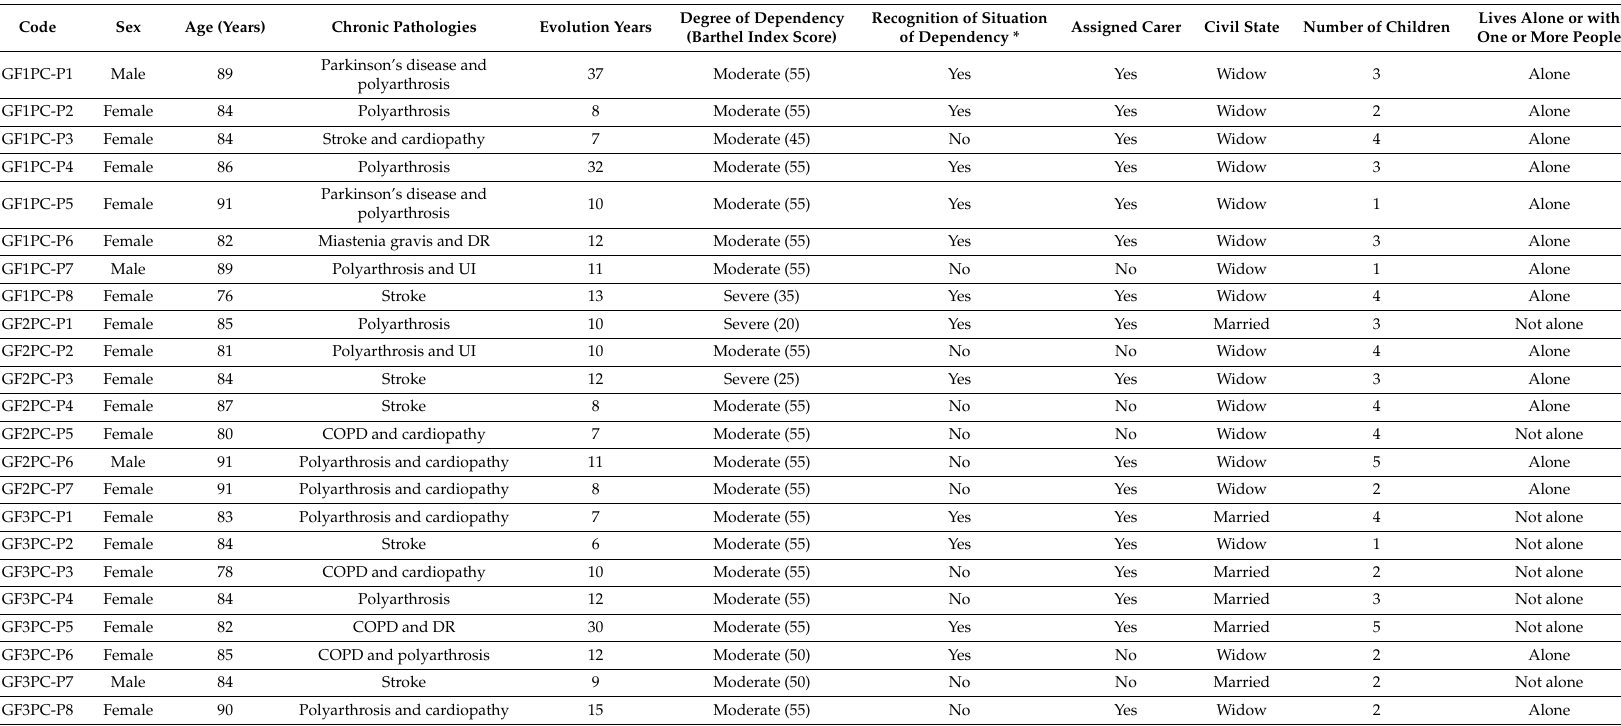
Table 1. Sociodemographic characteristics of the sample of people with chronic diseases and dependency